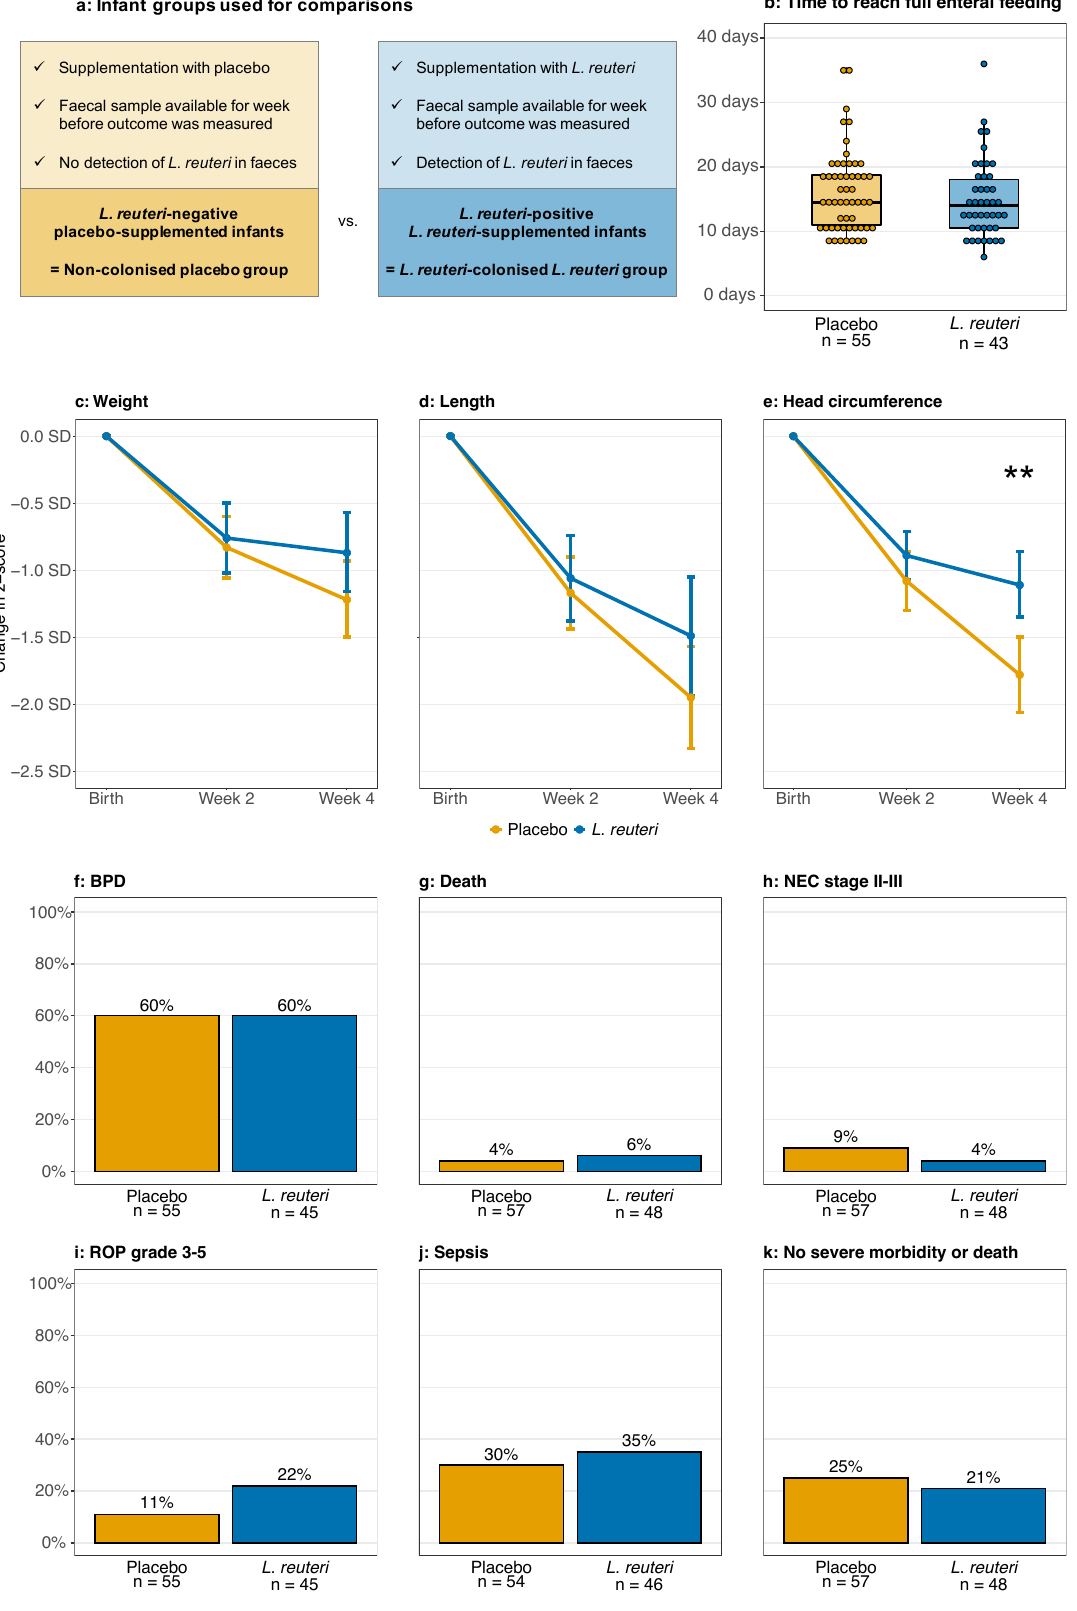
Figure 7. Growth and clinical outcomes in the L. reuteri -colonised L. reuteri -supplemented and non-colonised placebo group. ( a ) Criteria for selection of infants from the placebo and L. reuteri -supplemented groups for inclusion in the